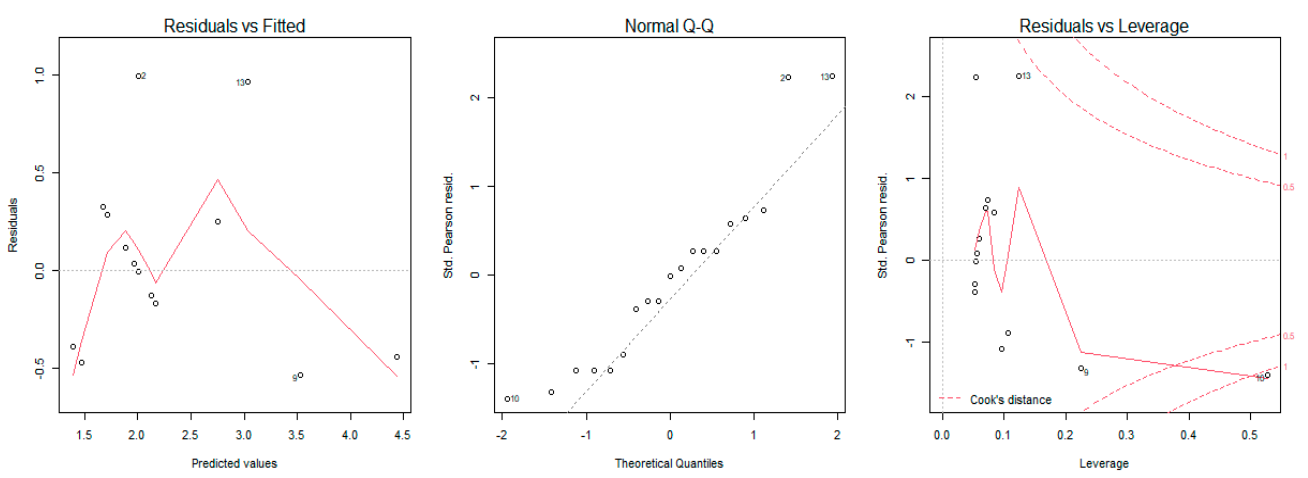
Figure 5. Graphical analysis of residuals for the MRC and Dynamometry model for Triceps Brachii muscle. The plot on the left shows the residual errors versus their estimated values; the QQ-plot in the center shows the distributive normality of the residuals; the plot on the right identifies any influential data points on the model.